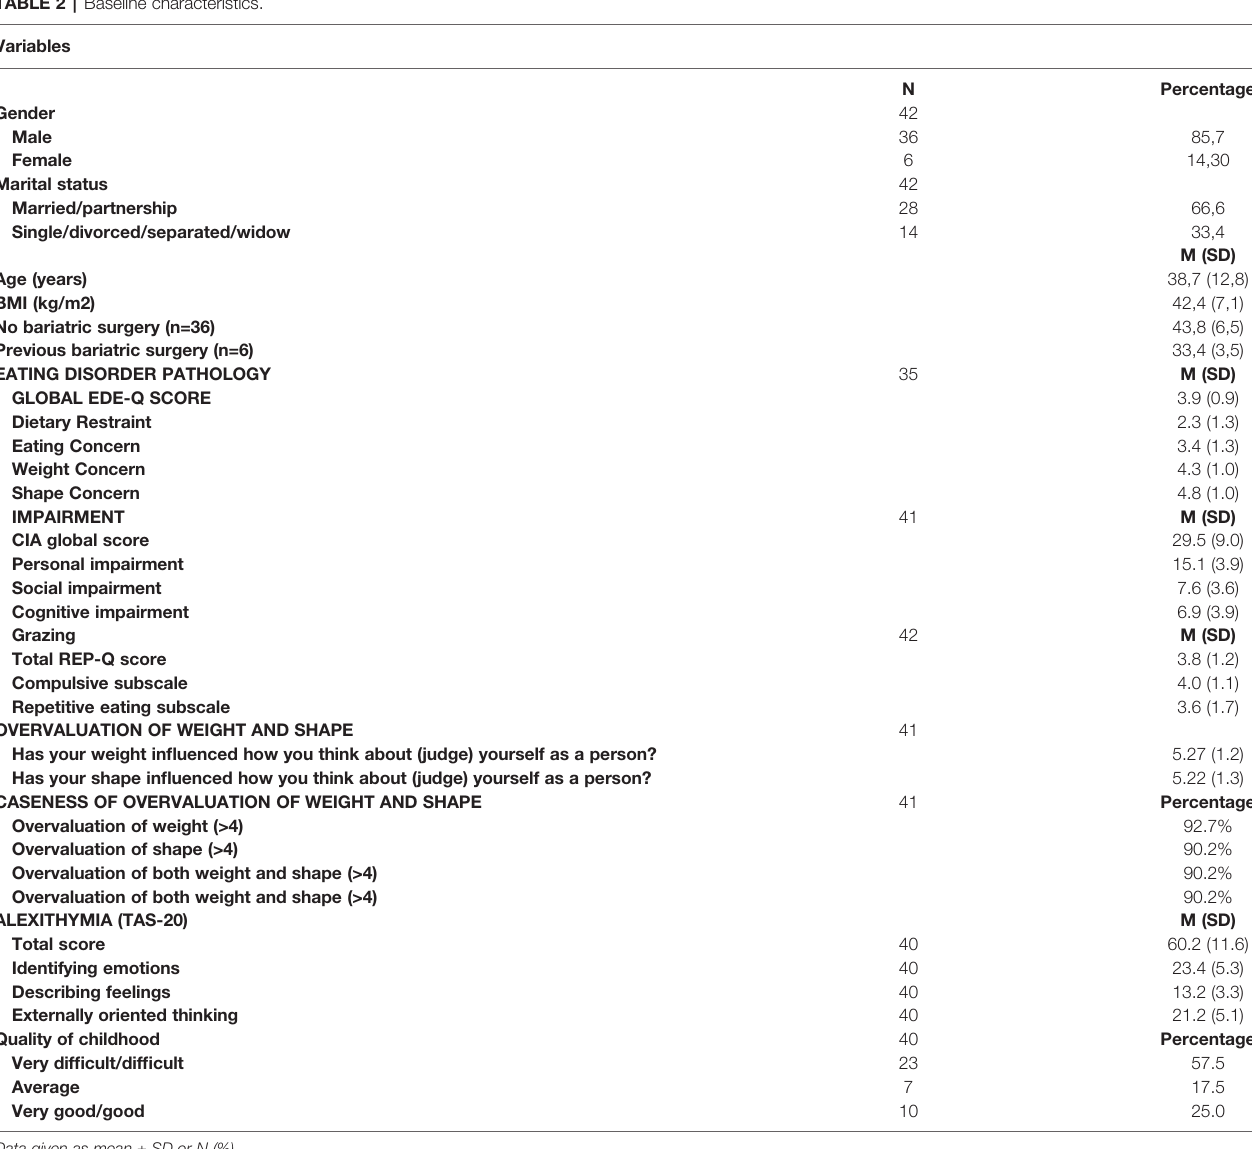
TABLE 2 | Baseline